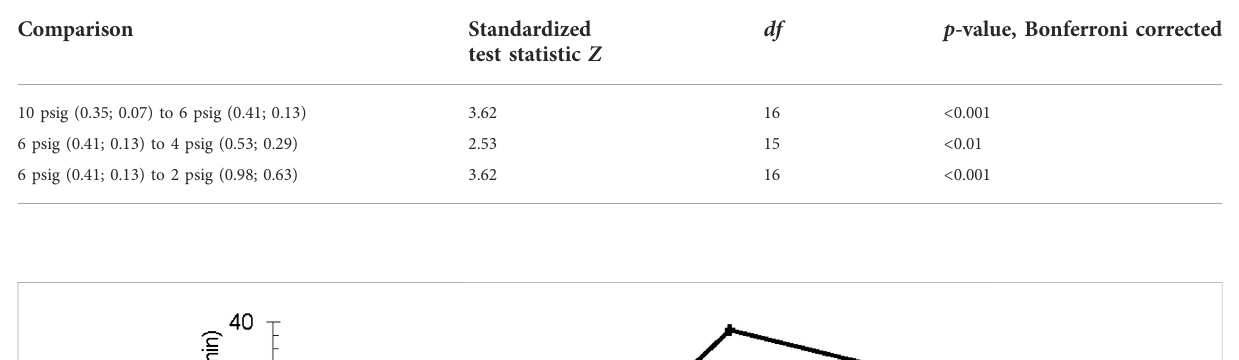
TABLE 4 Wilcoxon sign test of WOB i /V T for different regulator inlet pressures.